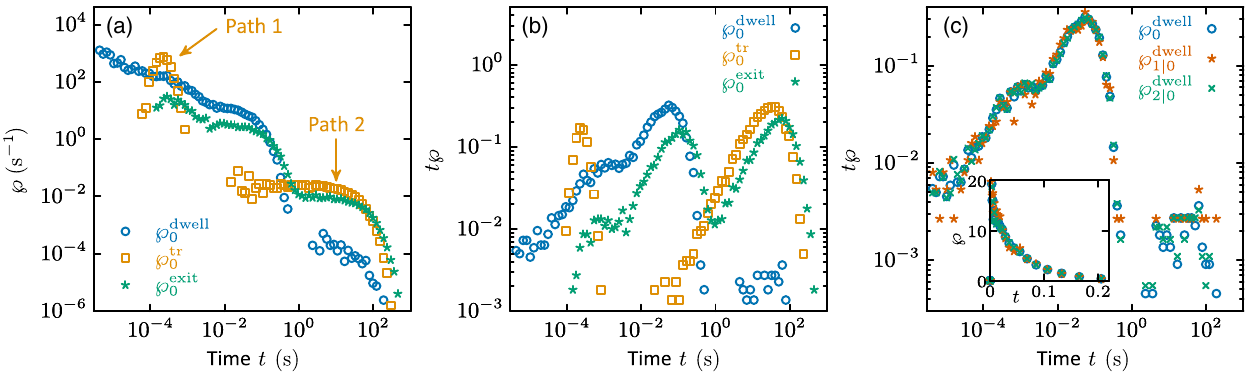
FIG. 19. Decomposition of the probability density of bond lifetime at pulling force F ¼ 30 pN into the probabilities of transition and dwell time, respectively. (a) Probability densities of bond lifetime ℘ exit , dwell time ℘ dwell , and transition time ℘ tr on a log-log scale. (b) Result from (a) where the probability densities are transformed to logarithmic densities t ℘ ð t Þ , which is normalized according to R R ∞ ∞ ℘ ð t Þ d ð ln t Þ ¼ ℘ ð t Þ dt ¼ 1 . (c) Test of ℘ dwell −∞ t 0